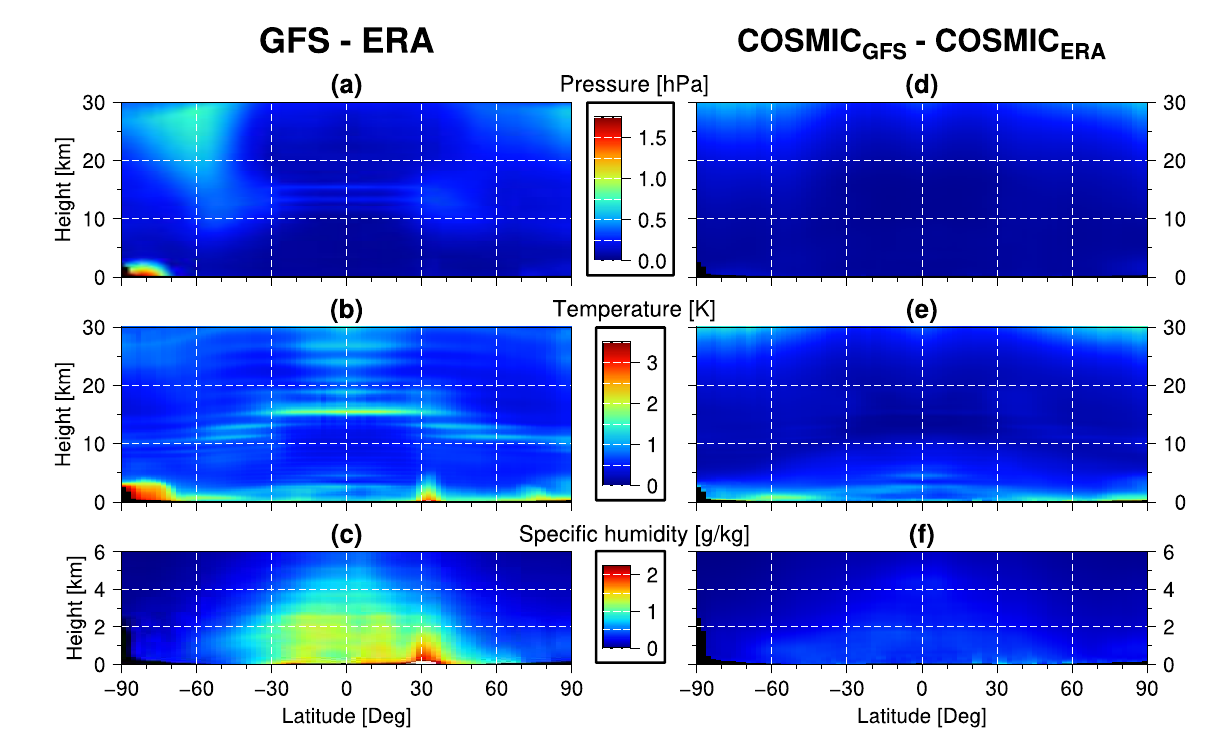
Figure 11. Root-mean-square differences for the years 2008–2014. Left panels are between the Global Forecast System (GFS) analysis of NCEP and the interim reanalysis (ERA) in: ( a ) pressure (hPa), ( b ) temperature (°C), and ( c ) specific humidity (g kg −1 ). ( d – f ) are the same as in ( a – c ) but for between COSMIC GFS and COSMIC ERA , which, respectively, use GFS and ERA as the background. Figure 12 compares COSMIC specific humidities with corresponding GFS and ERA at the height of 2.5 km (shown are RMSDs) from January 2008 to August 2014. The RMS difference between GFS and ERA (GFS-ERA; upper left panel) exhibits two sudden changes (marked A and B ), which coincide with the times that NCEP made major changes in their forecasting system [82,83]. The ECMWF reanalysis (ERA) uses a frozen analysis system and is thus unlikely to cause these sudden changes. When GFS is used as the background (denoted COSMIC GFS ), the 1D-Var departure from the background (GFS- COSMIC GFS ; upper right) resembles GFS-ERA. Thus, the 1D-Var produces a temporally continuous solution even though discontinuous background is given. While using ERA as the background (COSMIC ERA ), on the other hand, the background departure (COSMIC ERA - ERA; lower left) does not show any abrupt changes, confirming that neither COSMIC nor ERA but GFS is the cause of the sudden changes. The RMSD between COSMIC GFS and COSMIC ERA (lower right) is remarkably small, indicating that the 1D-Var produces almost identical humidity values regardless of the source of the background. The minor break appearing in COSMIC ERA -ERA at the end of 2013 seems to be caused by ERA, e.g., a change made to the observing systems used by the